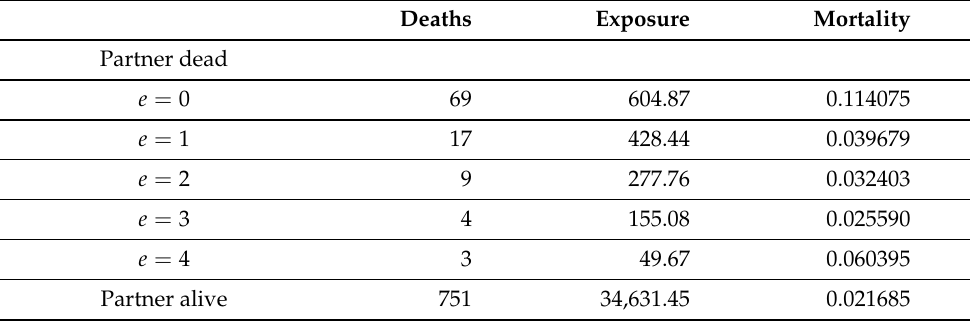
Table 2. Mortality for all couples, with e denoting the number of years since partner’s